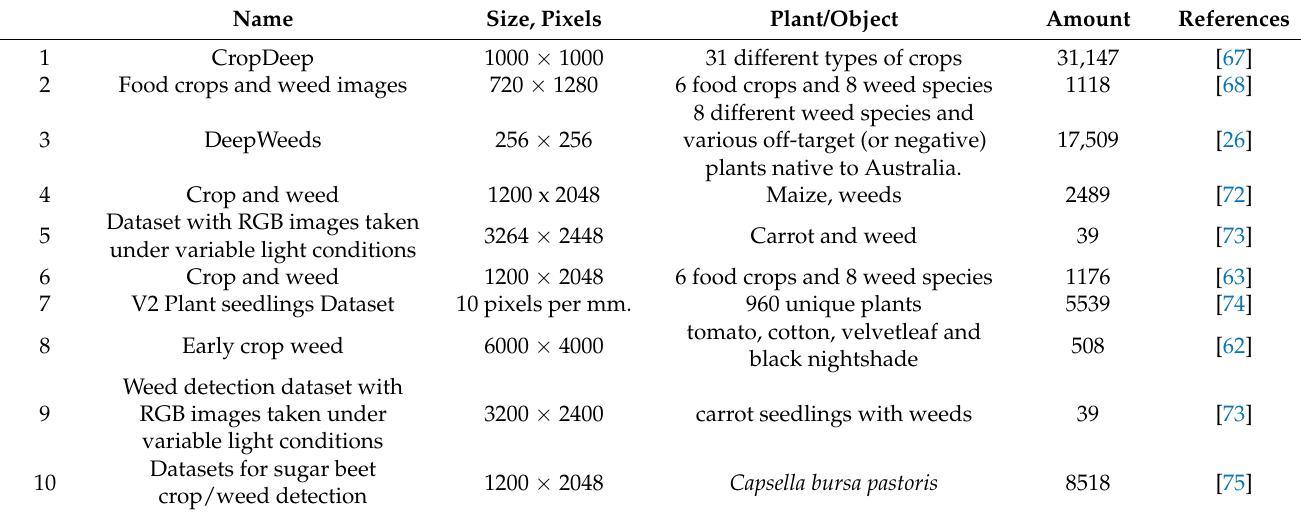
Table 1. Popular open weed image datasets.